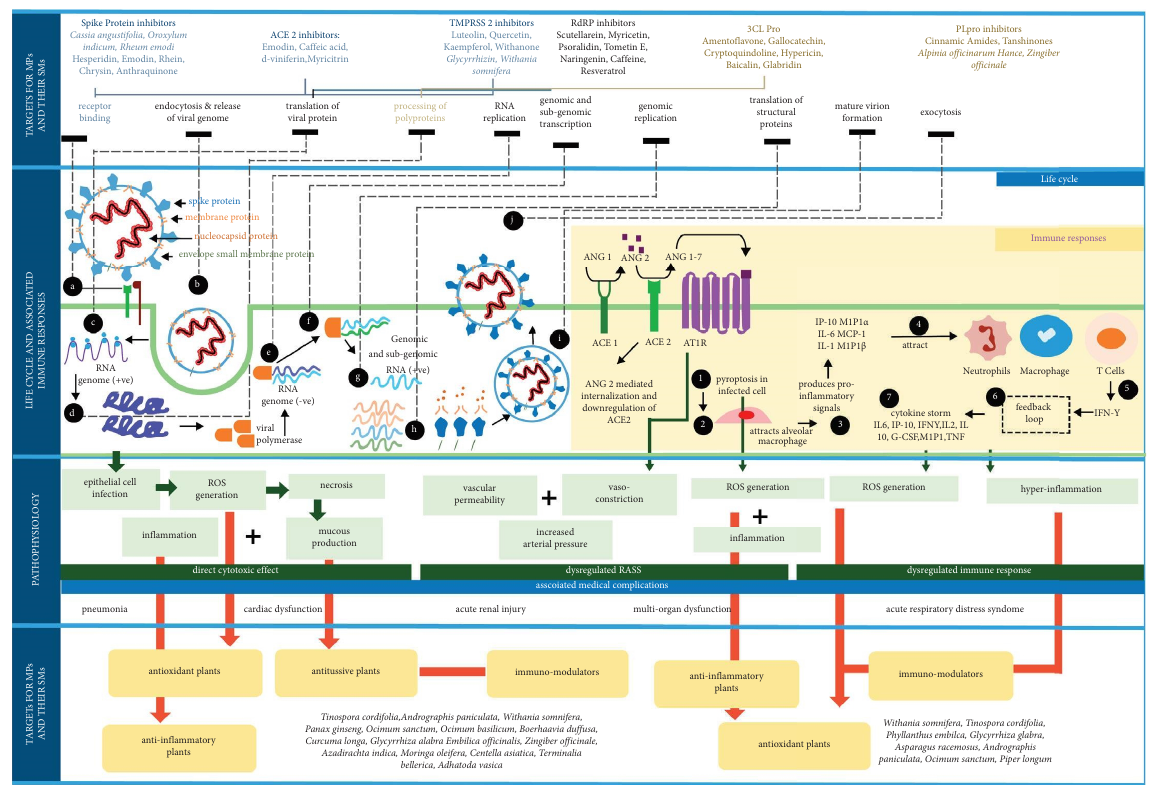
Figure 4: Life cycle of SARS-CoV-2, associated immune, and pathophysiological responses for identifying the targets and role of medicinal plants and their secondary metabolites against